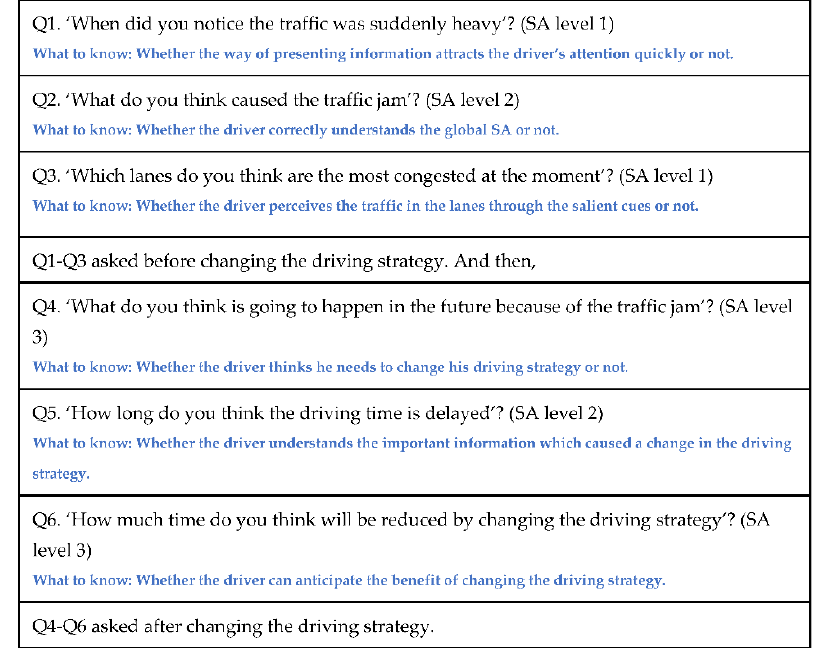
Figure 5. SA questions and what to know (Total of 6 questions) (Source: Own creation).